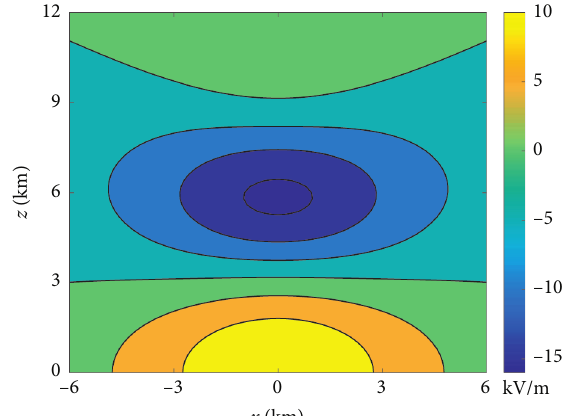
Figure 15: Contour of potential distribution on the longitudinal section while y � 4000m.